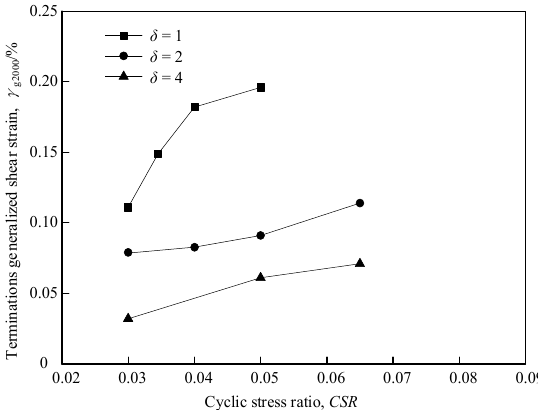
Figure 10. Relationship between terminal generalized shear strain and cyclic stress ratio.